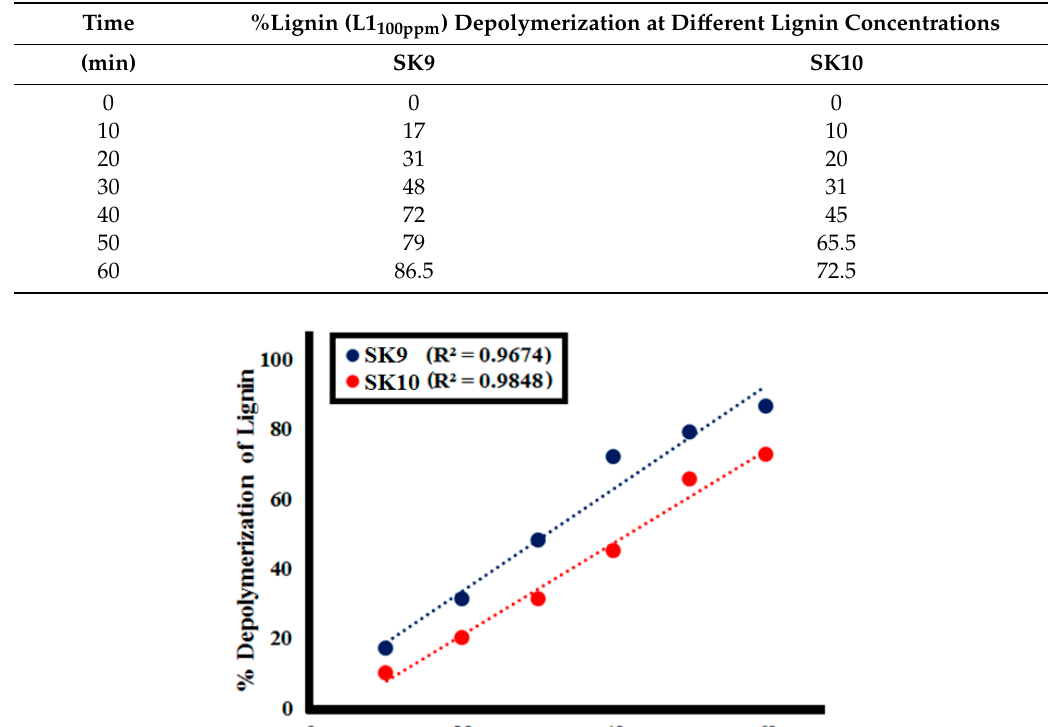
Figure 7. Photocatalytic lignin ( L1 100ppm ) depolymerization by 0.1 g SK9 and 0.1 g SK10 at different time intervals. Table 2. %Lignin ( L1 100ppm ) depolymerization by SK9 (0.1 g) and SK10 (0.1 g) at different time intervals.